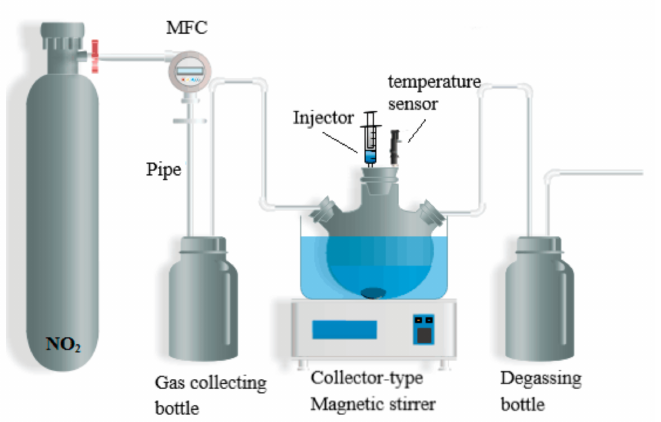
Figure 13. Schematic diagram of